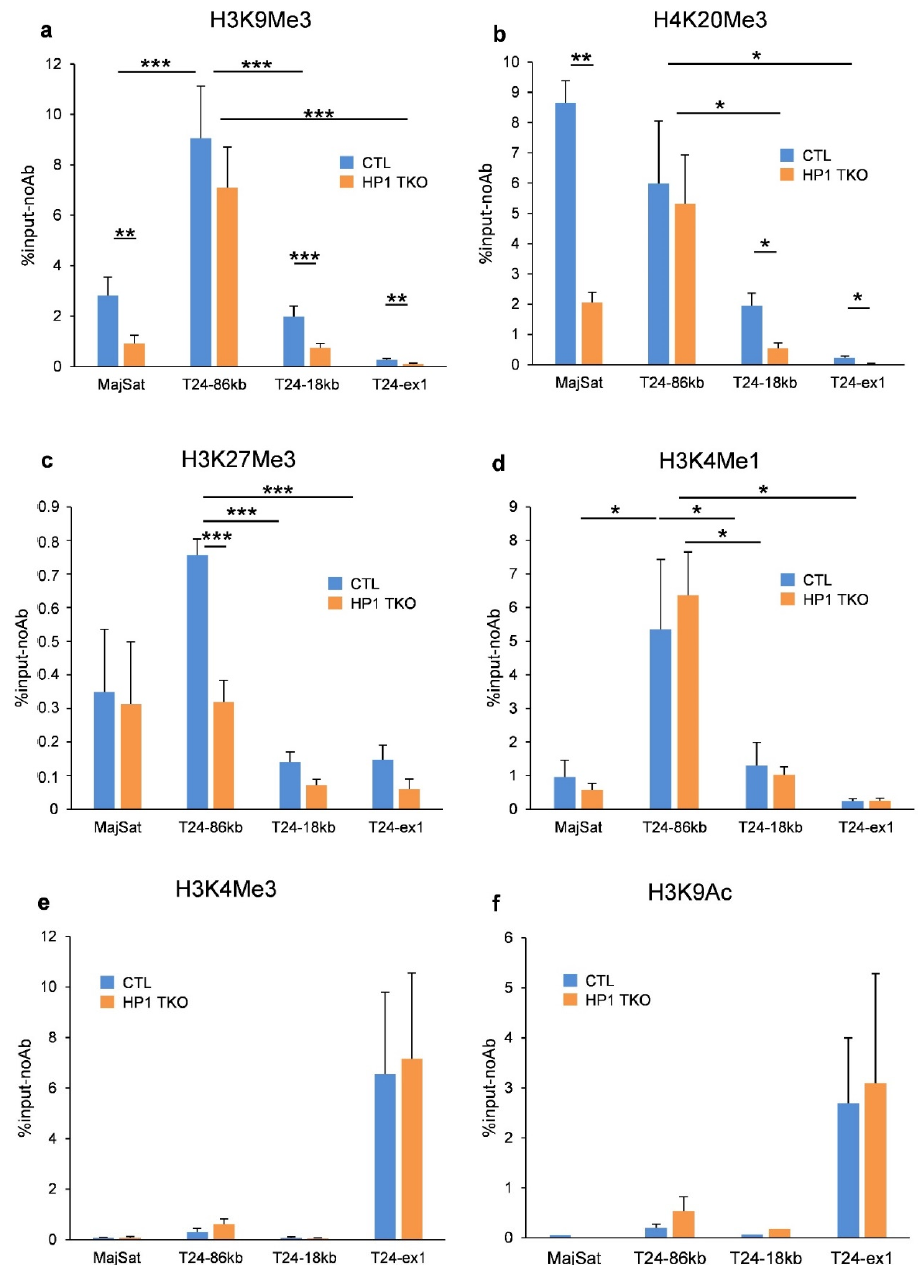
Figure 4. Epigenetic landscape at the Trim24 gene locus. ChIP-qPCR experiment showing the quantification of different histone modifications in control (blue bars) and HP1-TKO (orange bars) 8-week-old mouse livers at the major satellite repeats (MajSat), at the RLTR6-86 ERV (86 kb), the RLTR6-18 ERV (18 kb) and Trim24 exon1 (Trim24ex1). ChIP-qPCR quantifications are shown as the difference between the percentage of input with antibodies for the different histone modifications and the percentage of input in the absence of antibody (%input-NoAb). ( a ) H3K9me3, ( b ) H4K20me3, ( c ) H3K27me3, ( d ) H3K4me1, ( e ) H3K4me3 and ( f ) H3K9Ac. Error bars indicate s.e.m. of at least three biological replicates. p -values (Student’s t -test) indicate the difference in quantifications between control and HP1-TKO samples or between different genomic sites in control samples: p -value < 0.01 (***), p -value < 0.02 (**), and p -value < 0.05 (*).